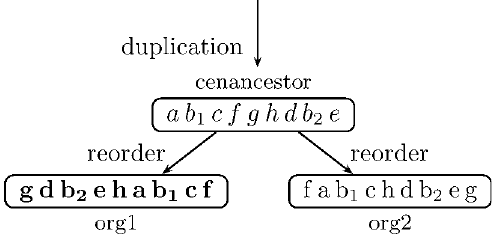
Figure 1. A Hypothetical Example Demonstrating the Definition of Positional Orthologs and the Emergence of a Nuisance Cross-Overlap A portion of the genomic segments in a hypothetical cenancestor is denoted by letters. Their orthologous segments in the descendant organisms org1 and org2 are given, using the same letters, but in different font (to stress that the segments, despite being orthologous, are similar but not identical). The scenario described in this example is as follows: a duplication of a genomic segment results in two duplicates b 1 and b 2 in the cenancestor. During the speciation of org1 and org2 the cenancestor genomic segments are shuffled. The orthologous segments b1 and b1 have similar genomic contexts and are thus positional orthologs. Similary b2 and b2 are positional orthologs as well. When comparatively mapping org1 and org2, one would find that b1 is similar to b2 and b2 is similar to b1. These hits obscure the deduction of the true evolutionary relation between b1 and b1 as well as between b2 and b2, and are referred to as nuisance cross-overlaps. In real biological examples, similar situations arise, e.g., because of rDNAs; see Figure 2. Notice also that, unlike in sequence alignment, and as is demonstrated in this example, duplications that occurred before the cenancestor (referred to sometimes as outparalogs [3]) may cause hardships when compara- tively mapping two organisms. Thus, nuisance cross-overlaps can be thought of as an ‘‘ ancestral curse. ’’ DOI: